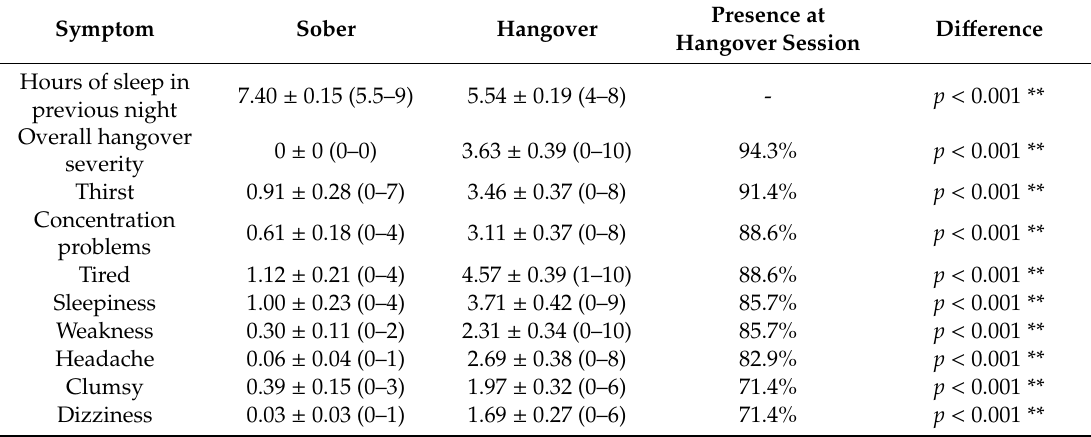
Table 2. Subjective ratings of sleep and hangover symptoms on both sessions. Hangover symptoms were rated on an 11-point Likert scale ranging from 0 points (no symptoms) to 10 points (extreme symptoms). Of note, participants were asked to truthfully rate the severity of each symptom on both sessions, irrespective of whether they had been drinking the night before the sober session. The mild symptom severity for the sober session and the resulting minimal variance of this rating may have contributed to the fact that nearly all hangover symptoms di ff ered significantly between the sober and the hangover session (as was intended by the study). These comparisons were performed with uncorrected paired t-tests. p -Values are reported in the column “Di ff erence.” All values are given as means ± standard error of the mean and